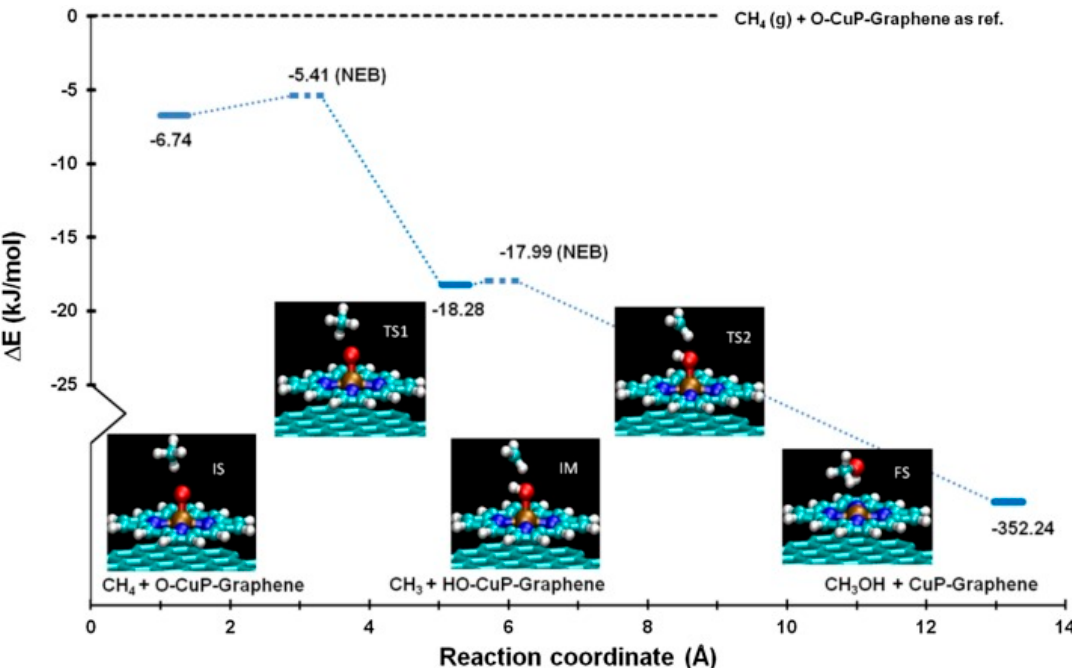
Figure 9. Reaction energy profile for the reaction of CH 4 with pre-adsorbed O atom on CuP functionalized graphene surface. The numbers indicate the energies relative to the reference system of gas phase CH 4 and O bound to the metal center of CuP functionalized graphene surface. The transition states are shown as the maxima on the energy landscape. The x-axis corresponds to the reaction coordinate along the reaction pathway. Reprinted with permission from reference [127] Copyright 2017 Elsevier.